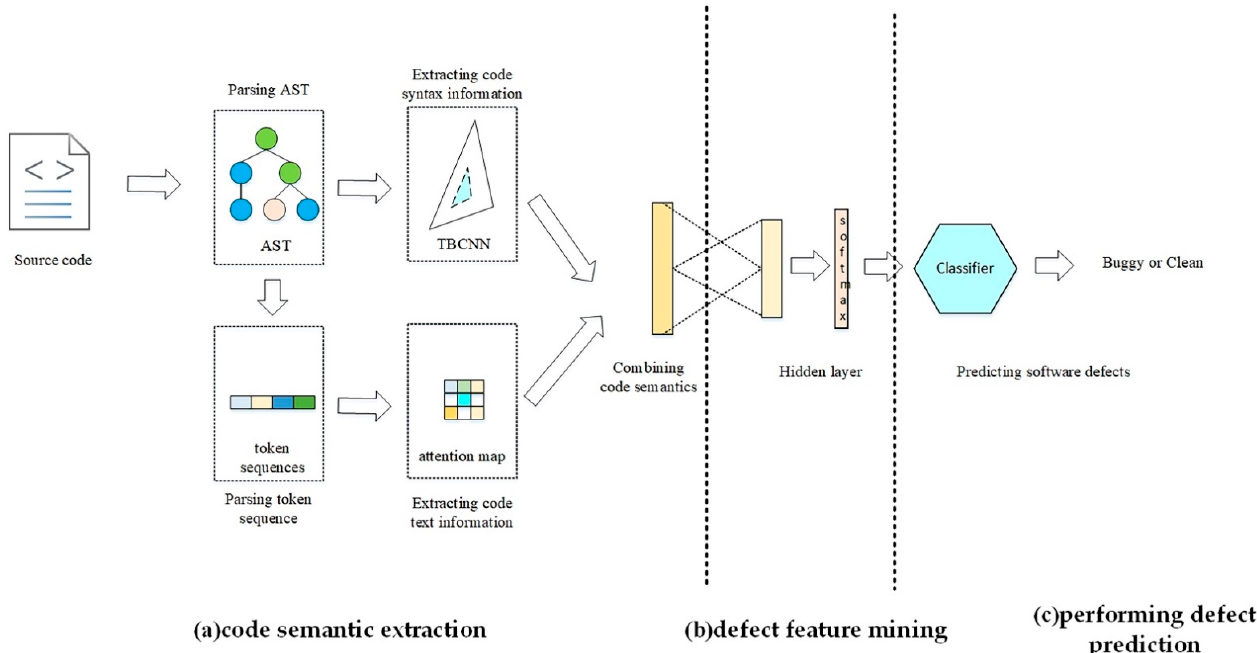
Figure 1. The overall framework of the PSFM method: ( a ) code semantic extraction, ( b ) defect feature mining, and ( c ) performing defect prediction.